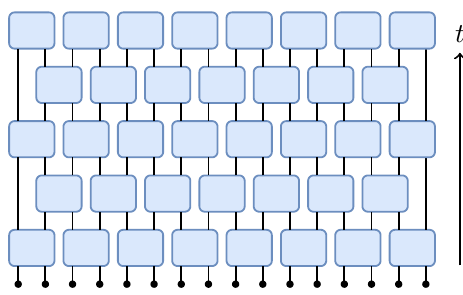
Figure 2 . A random quantum circuit on n qudits of local dimension q . Each layer is comprised of parallelized 2-site unitaries, where each gate is randomly sampled from U ( q 2 )